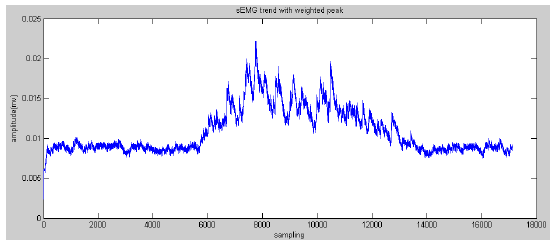
Figure 11. Results of weighted peaks of the reconstructed sEMG in node 4.0.